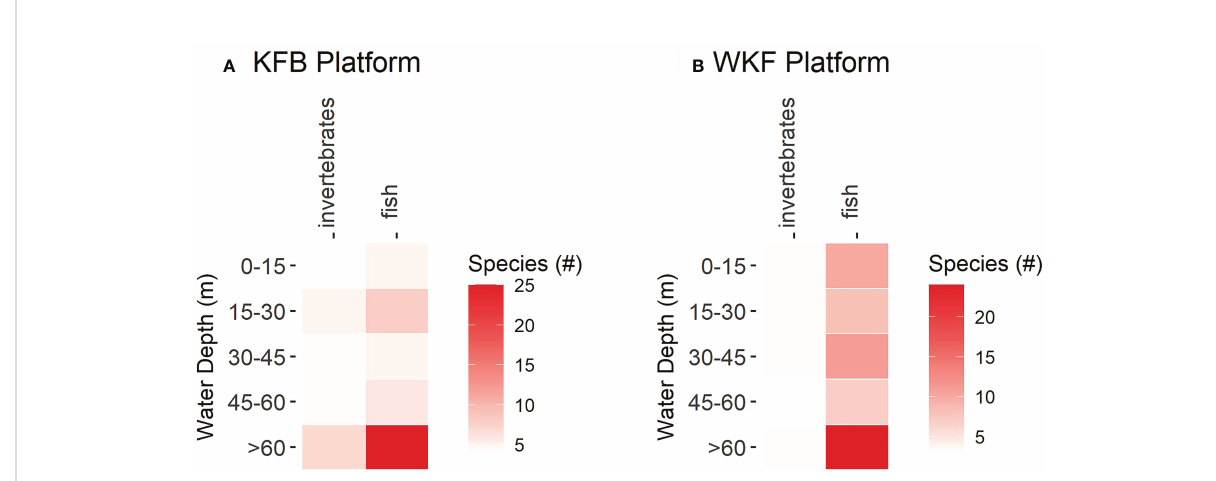
FIGURE 8 Heatmap showing species richness (total # of species) at platforms King fi sh B (KFB, A ) and West King fi sh (WKF, B ) surveyed for fi sh and invertebrates at the fi ve depth bands for which ROV imagery were surveyed (0 – 15, 15 – 30, 30 – 45, 45 – 60, – 60 m). Only one species of mammal, the Australian fur seal, Arctocephalus pusillus doriferus , was found.